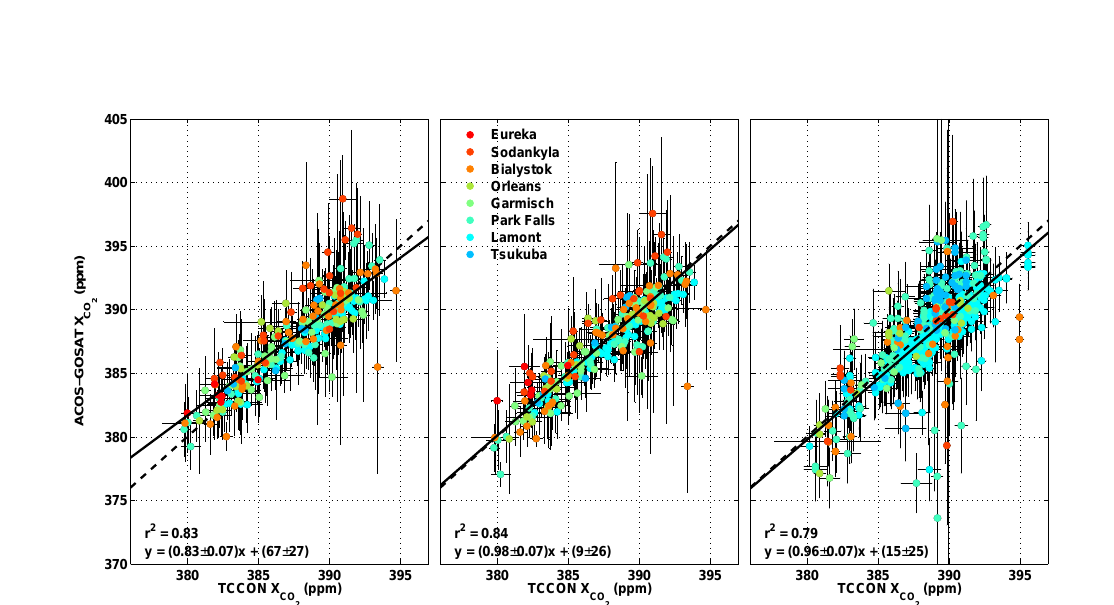
Fig. B1. The left two panels show the regression between TCCON and ACOS-GOSAT v2.9 data using the T 700 coincidence criterion. The left panel shows the unmodified data. The middle panel shows the regression after applying Eq. (4) but with the coefficients described in Appendix B. The right-hand panel shows the regression after applying Eq. (4) with the coefficients described in Appendix B, but using coincidence criteria that restricts latitudes to within ± 0 . 5 ◦ , longitudes to within ± 1 . 5 ◦ , and interpolates the TCCON data onto the ACOS- GOSAT measurement times. Note that there are no coincident data over Eureka when using the geographic coincidence criteria (right-hand panel). The solid lines show the best fit to the data (with equations and ± 2 standard errors shown on the plot), and the one-to-one line is plotted as a dashed line. The vertical bars represent the ± 2 σ variability of the ACOS-GOSAT data, illustrating the dependence of the variability of the ACOS-GOSAT data at each TCCON value (i.e., var( y | x )) in the regression. Similarly, the horizontal bars represent the ± 2 σ variability of the TCCON